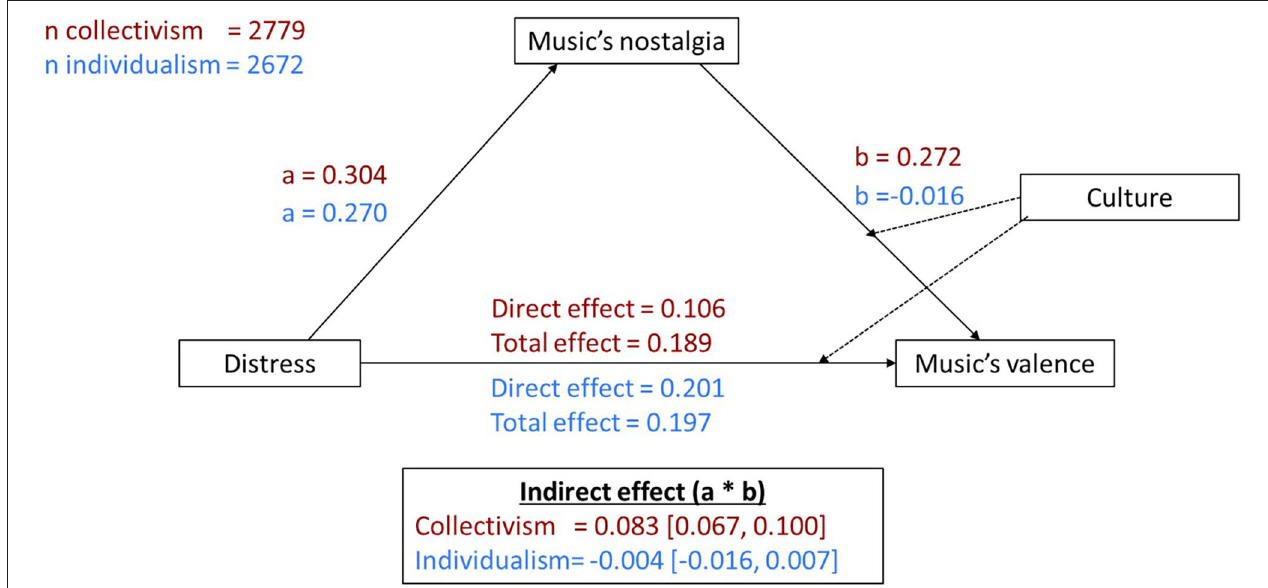
FIGURE 5 | Moderated-mediation model. X, distress; Y, music valence; Mediator, music nostalgia; Moderator,